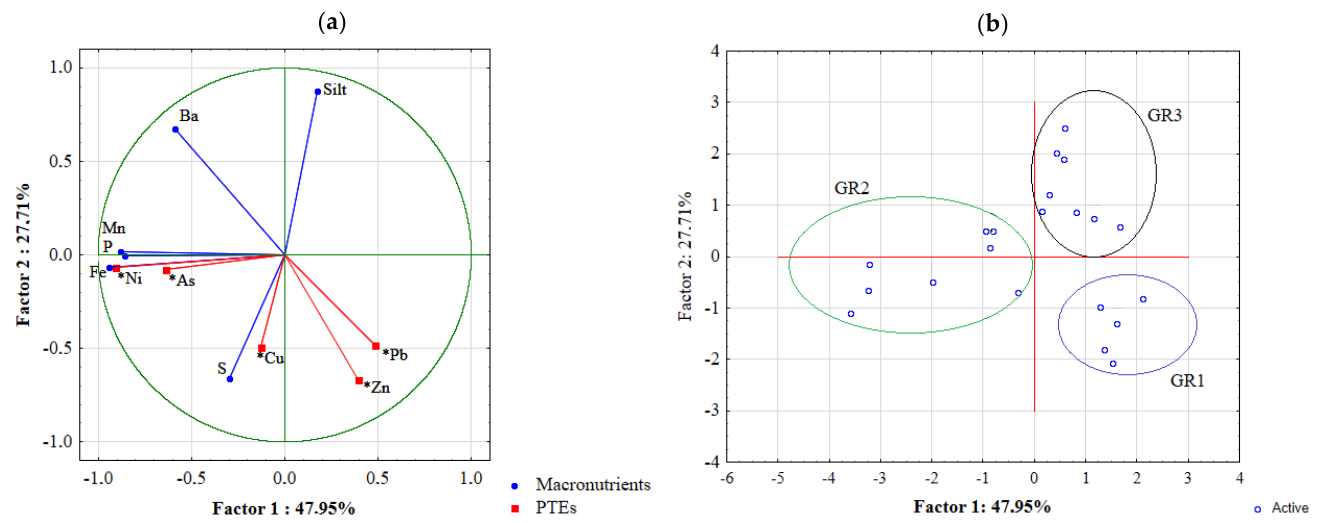
Figure 2. Principal component and classification analysis output: ( a ) Scatterplot of variables correlations; ( b ) Scatterplot of case correlations.